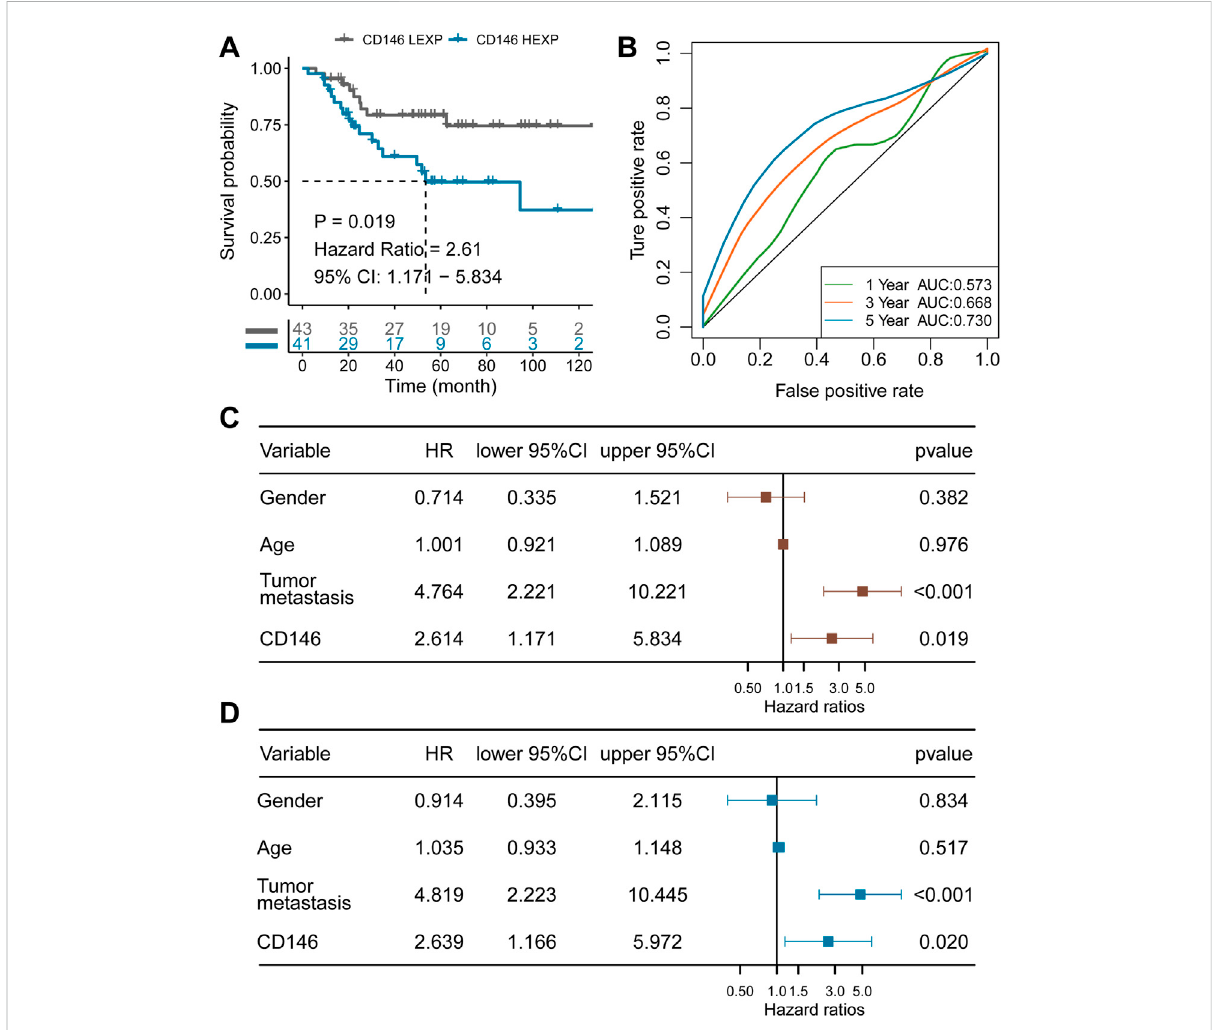
FIGURE 3 CD146 is an independent prognostic factor for OSA identi fi ed in the TARGET-OS cohort. (A) K-M plot showing the diverse clinical overall survival outcomes of the CD146 low and high groups; (B) ROC curve showing the prognostic value of the CD146 expression level; (C) results from univariateCoxregression analysis oftheCD146 group andclinicalfeatures; (D) results frommultivariate Coxregressionanalysis oftheCD146 group and clinical